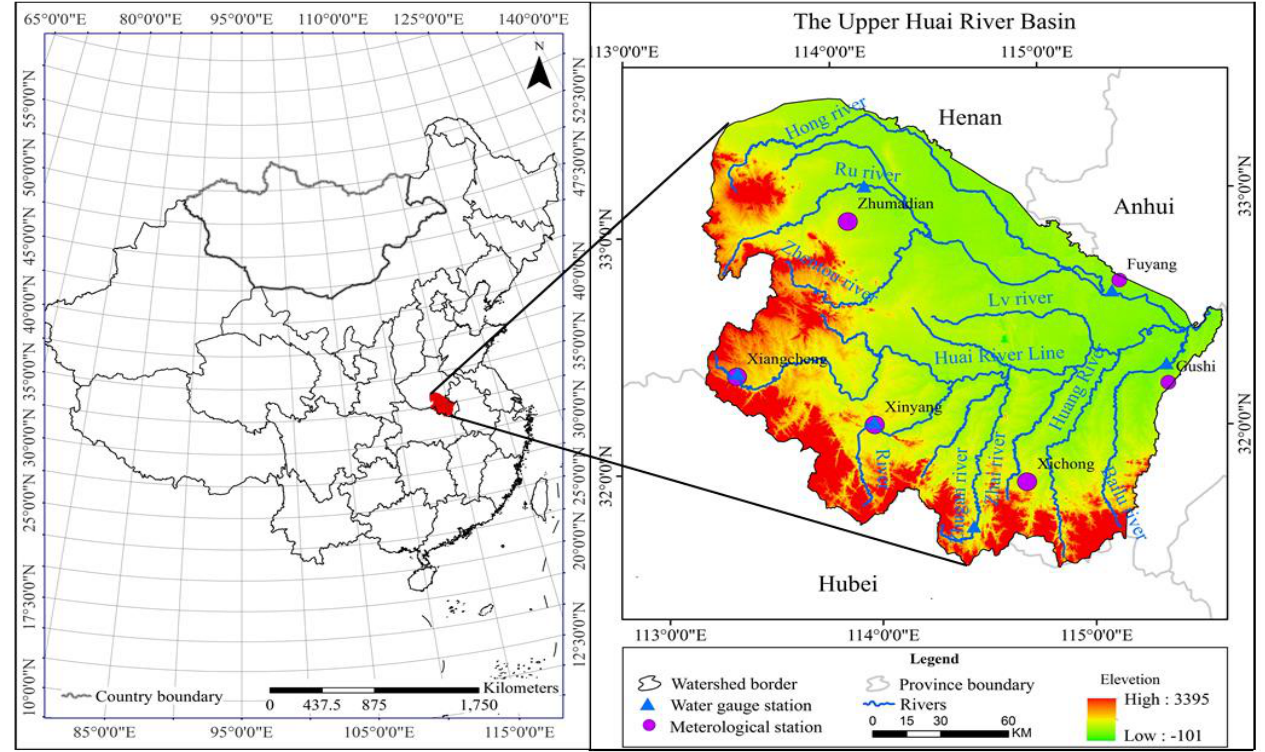
Figure 1. Location map of the Huai River Basin and drainage.